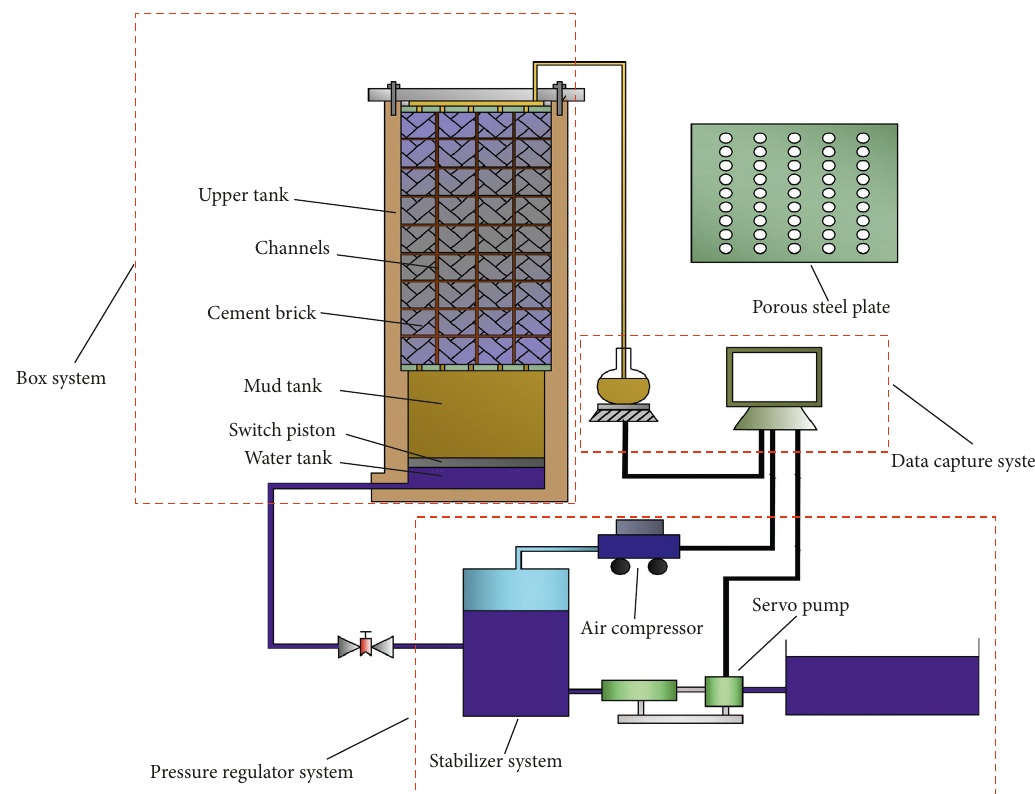
Figure 5: The skeleton of mud-water inrush through rock fractures.